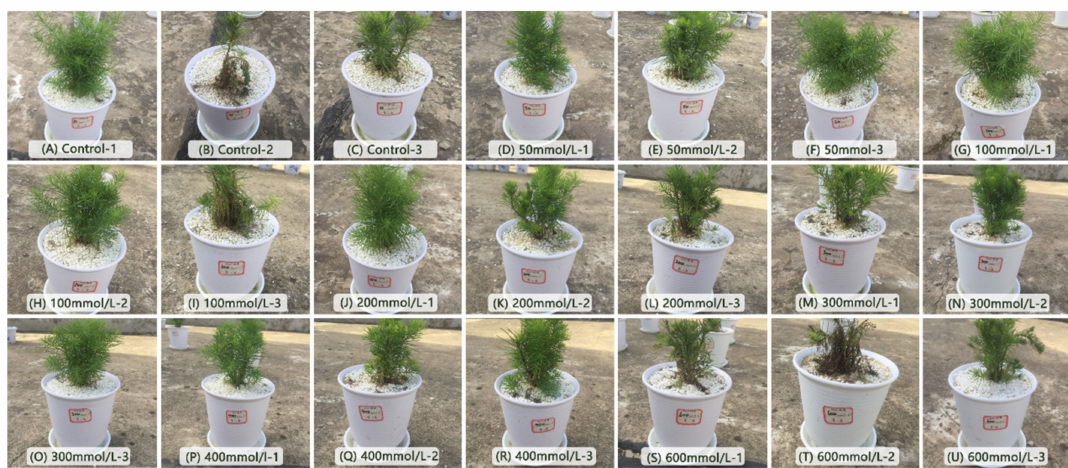
Figure 2. Photographs of potted plants of Suaeda salsa under salt stress in seven groups (taken on